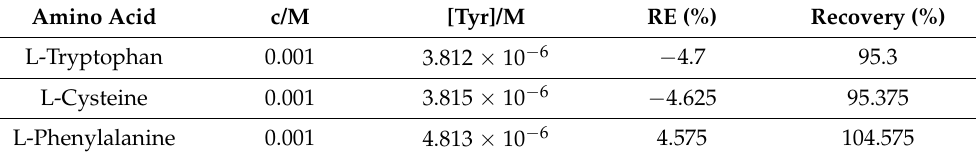
Table 8. The interference of several amino acids on the quantification of 4 × 10 − 6 M L-Tyr. Amino